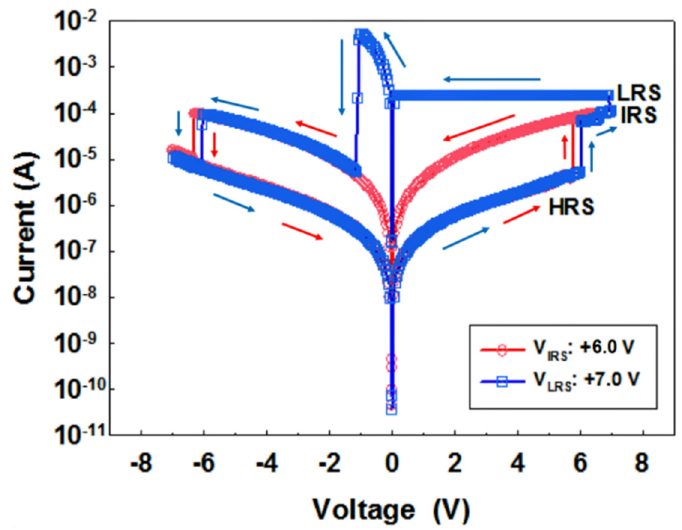
Figure 2. Typical I-V characteristics of an Au / Ni / SiO x N y / p + -Si memory device with I COMP = 0.25 mA.